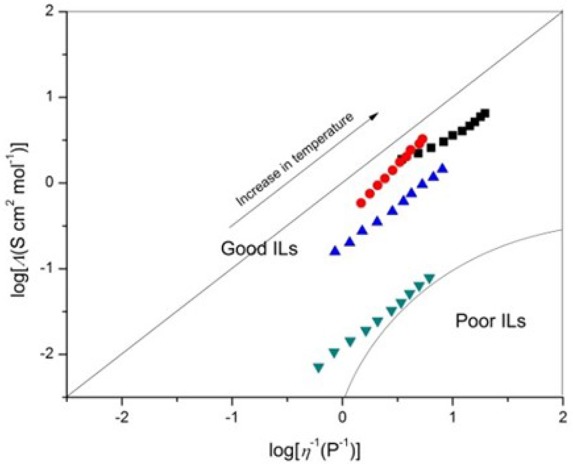
Walden plots of log(molar conductivity, Λ) against log(reciprocal viscosity η−1), [C4mim][N(CN)2] (black), [C4m2im][N(CN)2] (red), N4442[N(CN)2] (blue), and N8444[N(CN)2] (green).